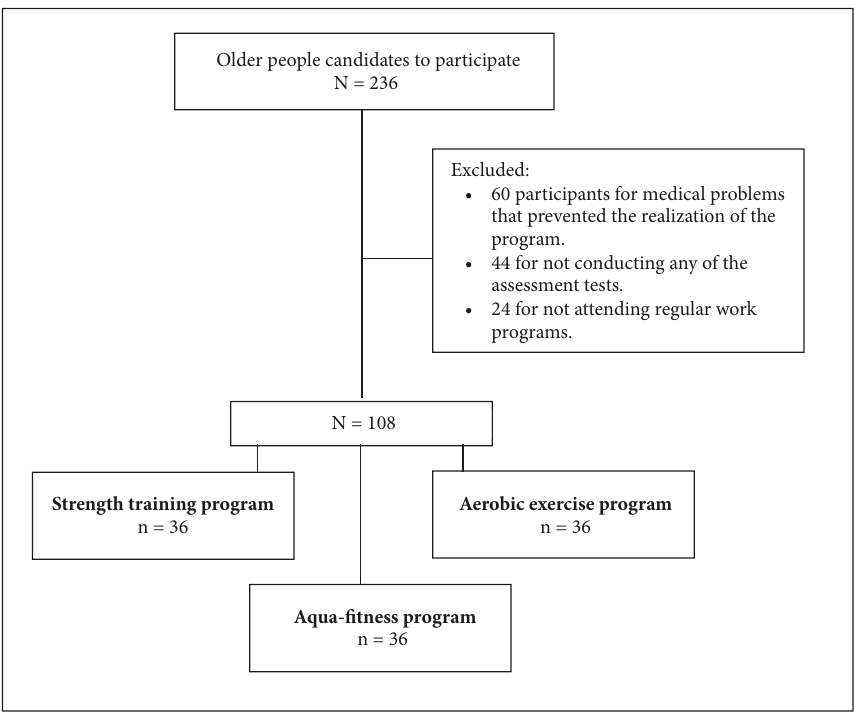
Figure 1: CONSORT flow